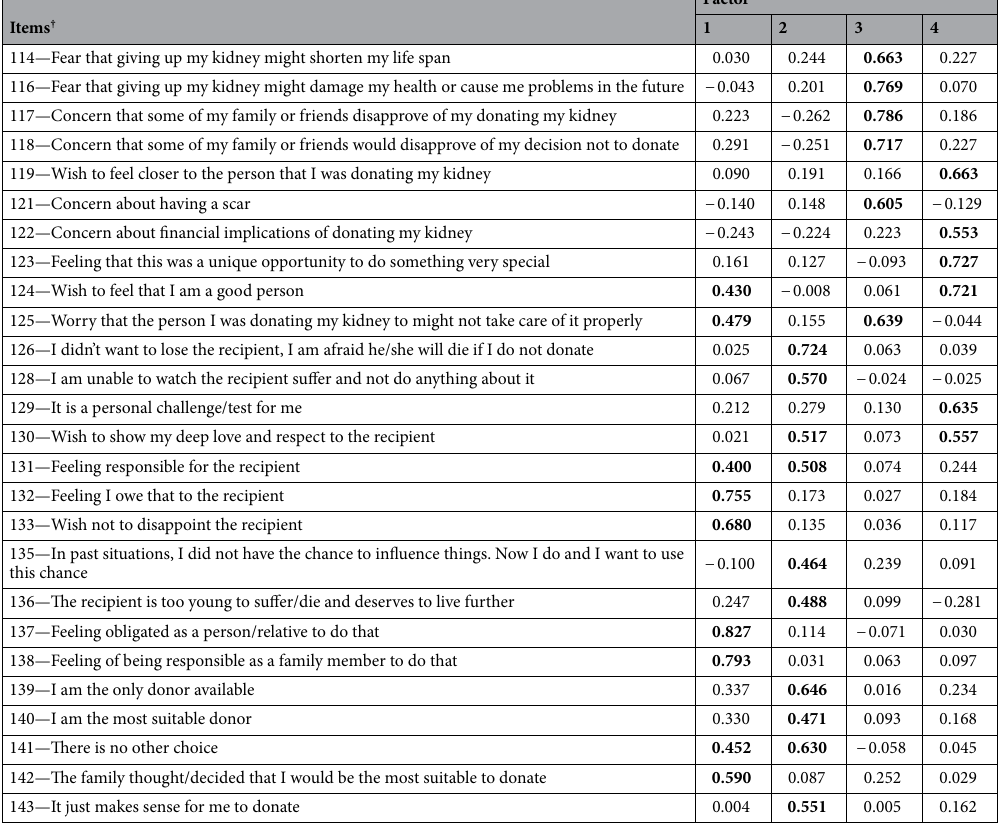
Table 1. Principal component analysis of motivations for donation. Bold values are the items cross-loaded in each factor. † Likert scale for all the items from 1 (not relevant) to 5 (very